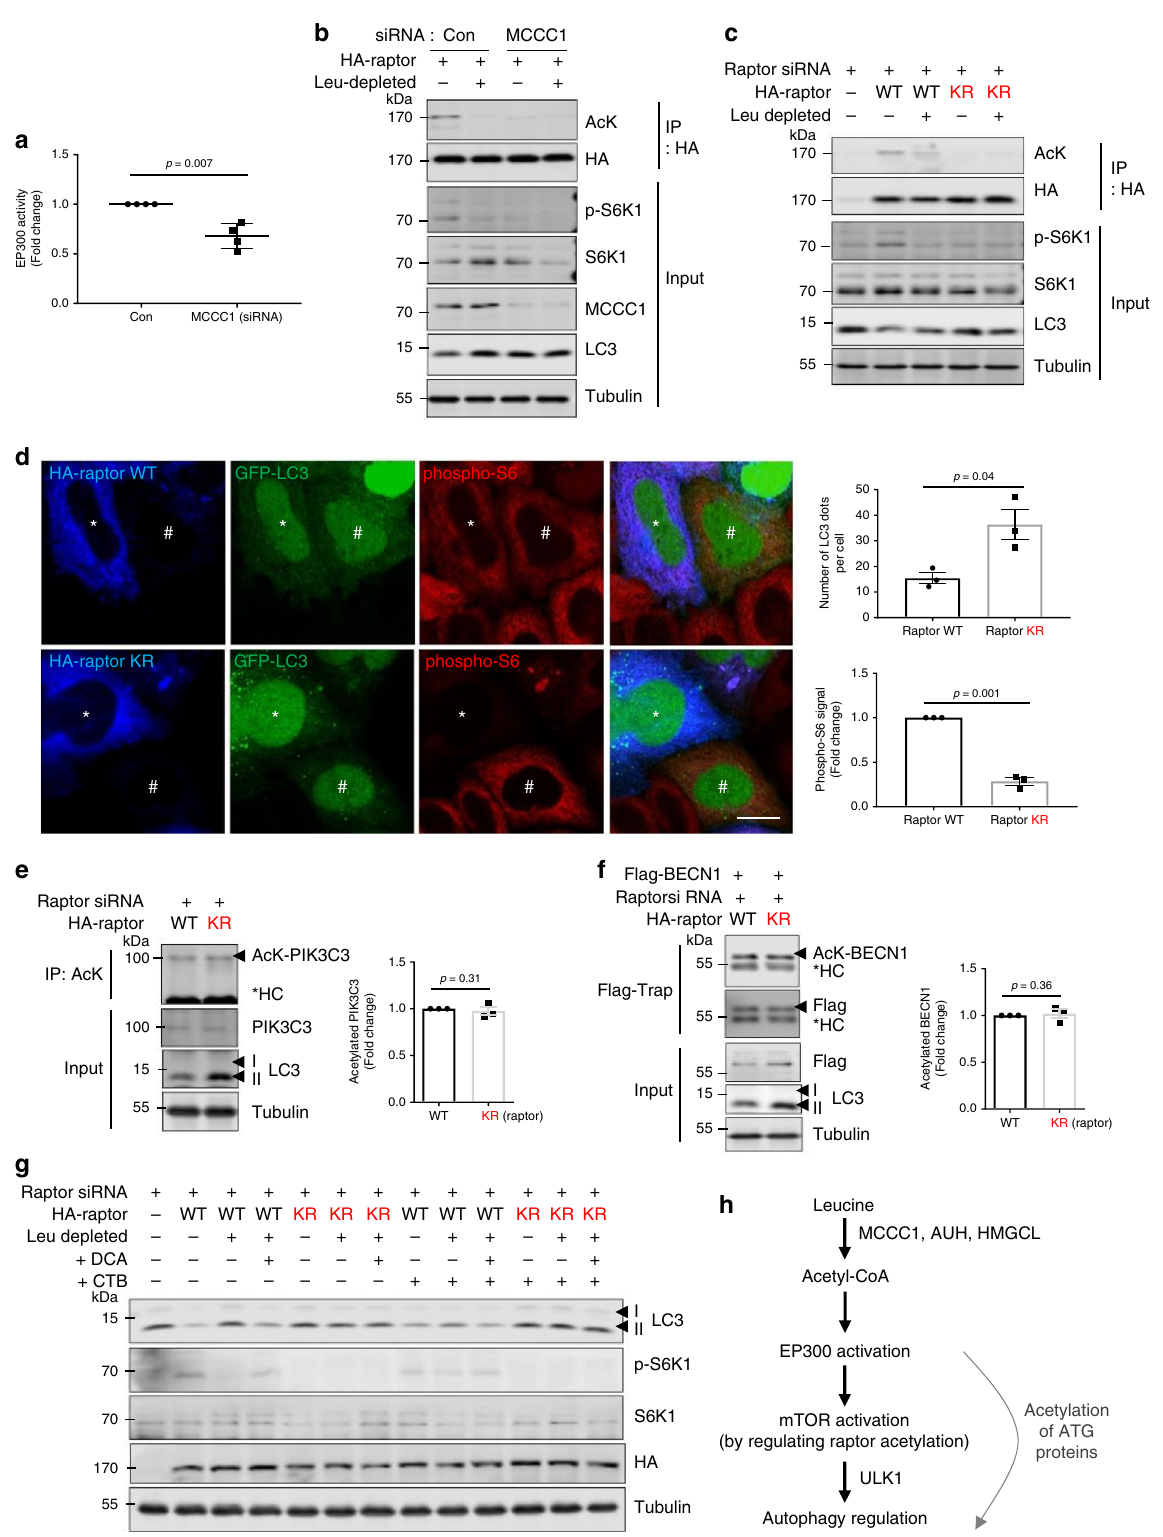
Fig. 11c), and observed signi fi cant correlations between AcCoA- levels and acetylated raptor levels, and negative correlations between AcCoA and LC3-II, and acetylated raptor and LC3-II (Supplementary Fig. 12a – f), compatible with our cell culture